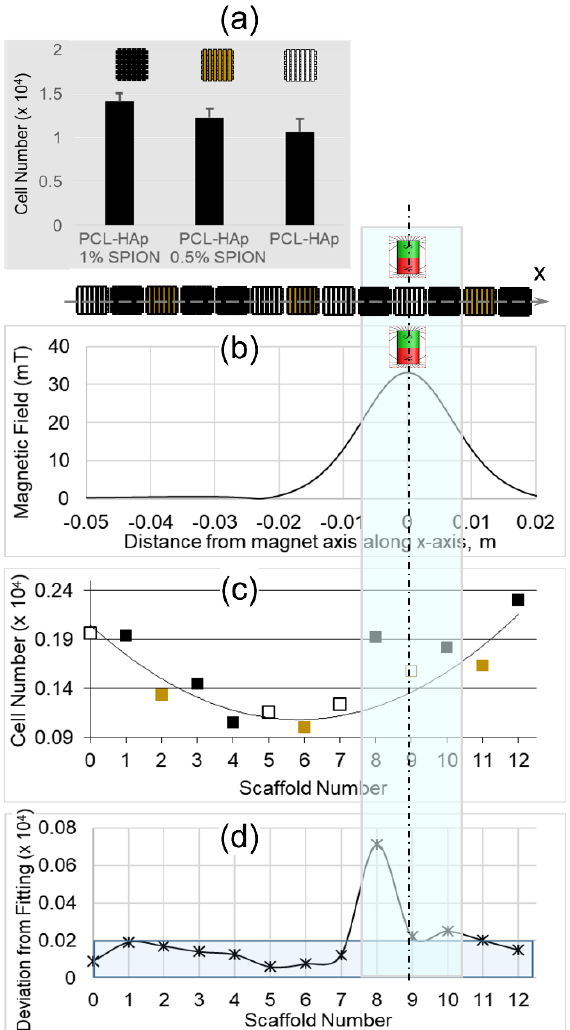
Figure 2. Cell seeding in the scaffolds with various levels of magnetization: ( a ) Number of the cells seeded in the single scaffolds; ( b,d ) Cell seeding in the array of 13 scaffolds (cyan highlighted area corresponds to maximal magnetic field intensity): ( b ) Magnetic field distribution along the scaffold centers ( x -axes); ( c ) Cell amount seeded in the scaffolds and the fitting line the color of markers indicates the scaffold magnetization, while the scaffold numbers correspond to those indicated in Figure 1; ( d ) Deviation values of the loaded cell number from the fitting line.